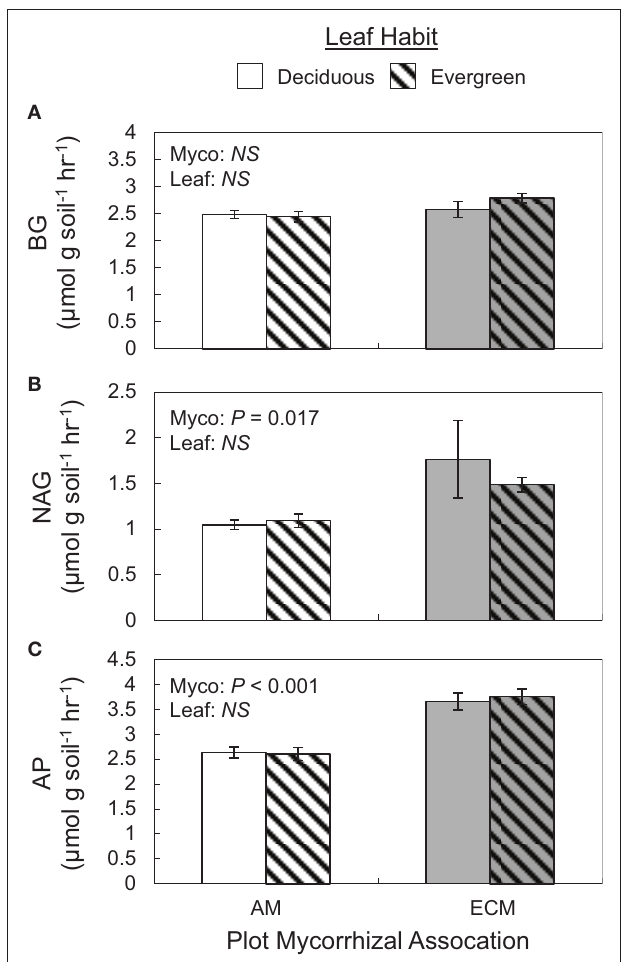
FIGURE 4 | Potential soil extracellular enzyme activities of β -1,4-glucosidase (BG) (A) , N -acetyl- β -d-glucosamidase (NAG) (B) , acid phosphatase (AP) (C) in forestry plots at The Morton Arboretum. Bars are mean ratios; one standard error of the mean is presented. open bars, deciduous plots; hatched bars, evergreen plots; white bars, AM plots; gray bars, ECM